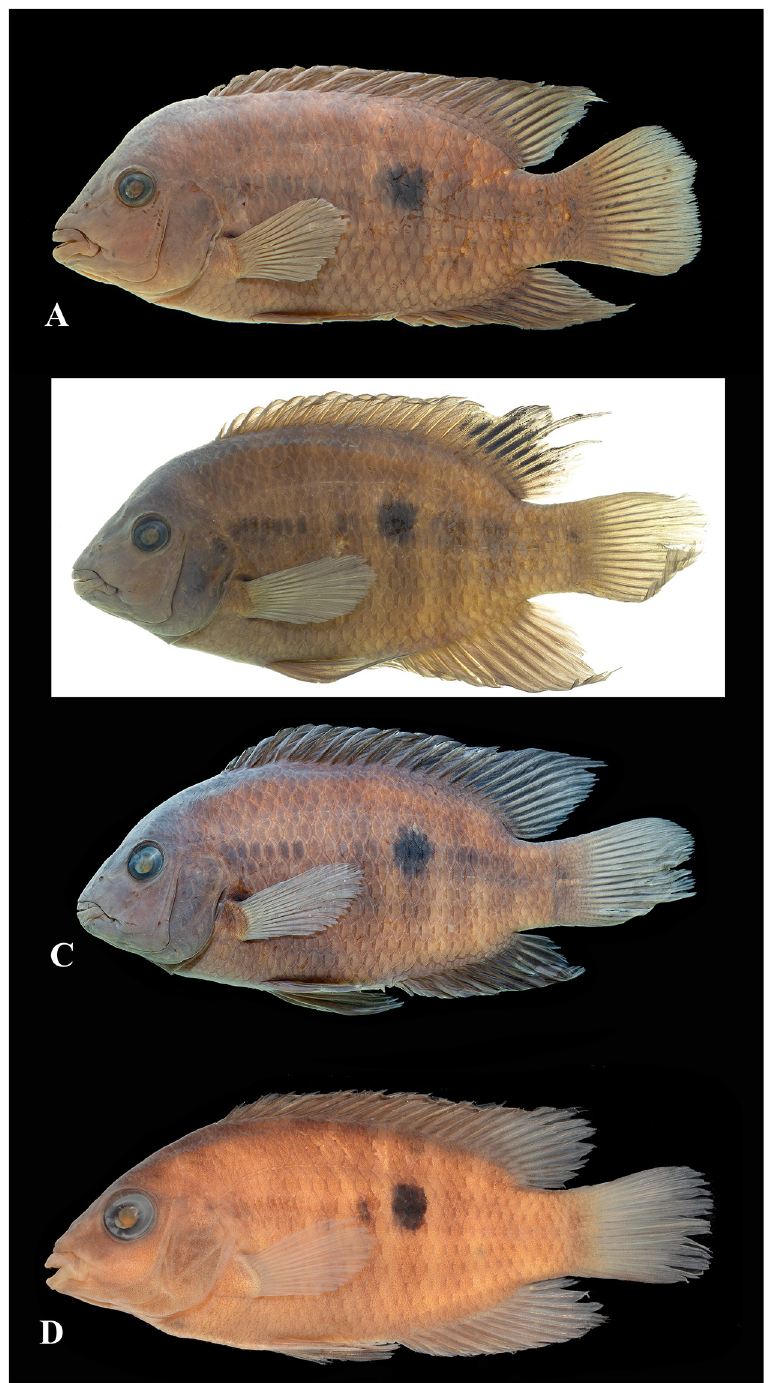
Fig 26. Australoheros mboapari. A . holotype, MCP 49000, adult male, 101.7 mm SL; Brazil: Rio Grande do Sul: Antoˆnio Prado: Rio Taquarı´drainage, Quaresma, close to the Rio das Antas. B . Paratype, adult female, 95.1 mm SL: MCP 33554; Brazil: Rio Grande do Sul: Nova Roma do Sul: Rio Taquari drainage: Arroyo do Carma, near mouth in the Rio das Antas. C. Paratype, young male, 81.1 mm SL: MZUSP 33554; Brazil: Rio Grande do Sul: Nova Roma do Sul: Rio Taquari drainage: Arroyo do Carma, near mouth in the Rio das Antas. D. paratype, juvenile, 39.3 mm SL; MCP 23044; Rio Grande do Sul: Rio Taquari drainage: Antoˆnio Prado: Rio Toro, on the road from Vila Flores to Antoˆnio